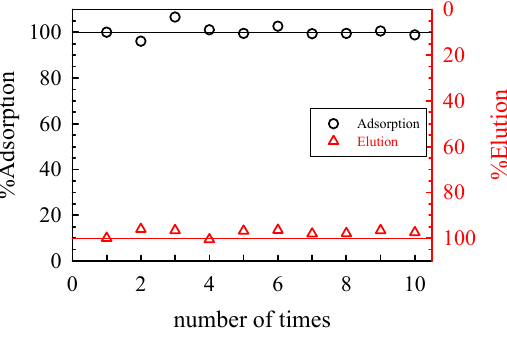
Figure 18. % adsorption and % elution of Pb(II) when a column packed with SOJR gel was repeatedly loaded with Pb(II) and eluted.